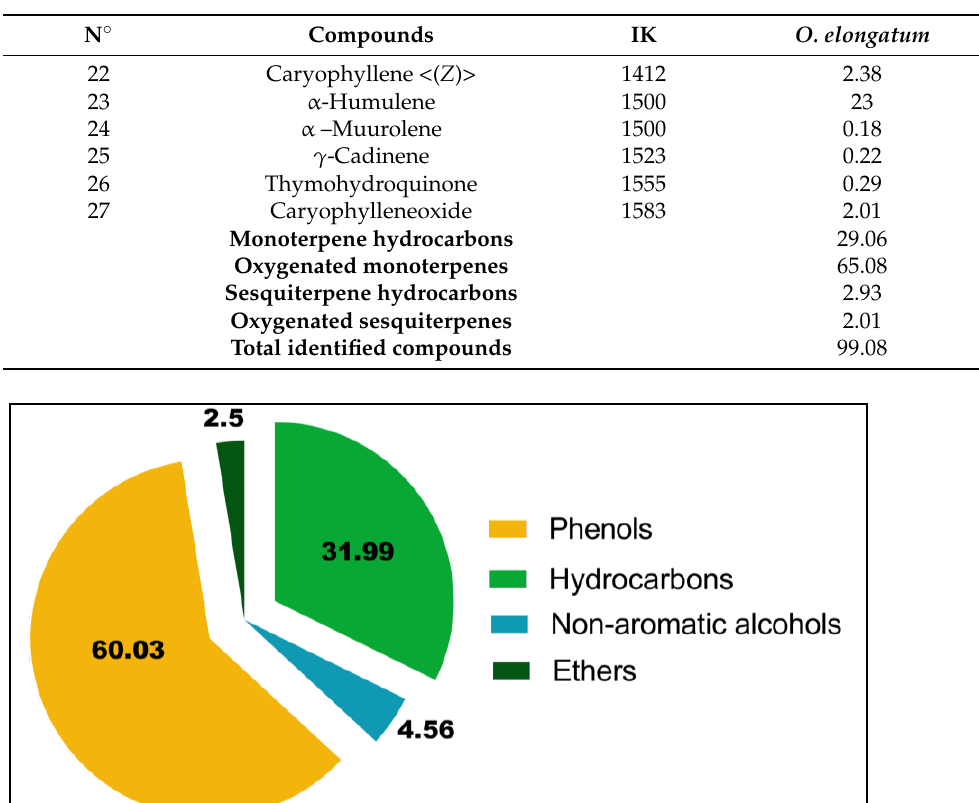
Figure 1. Chromatogram of the O. elongatum EO.